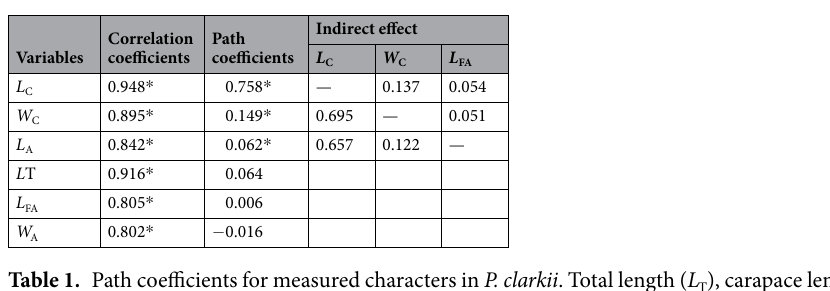
Figure 4. Estimates of the migration ( M and θ ) ( A ) and skyline plots among three geographic regions of crayfish ( B ). Θ represents the mutation-scaled population size, and the value M in ( A ) indicates the mutation- scaled migration rate. Θ 1, θ 2, θ 3 represents the population sizes of Huai River, lower reaches and UM regions of Yangtze River basin, respectively. The map in ( A ) was generated by ArcGIS 10.2.